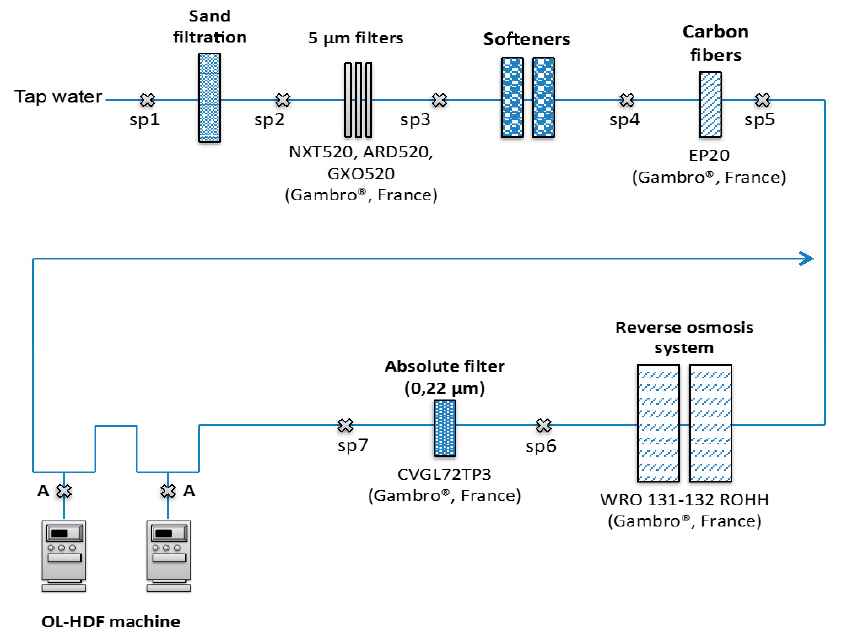
Figure 1. Schematic representation of water purification process and water sample location ( : SP).